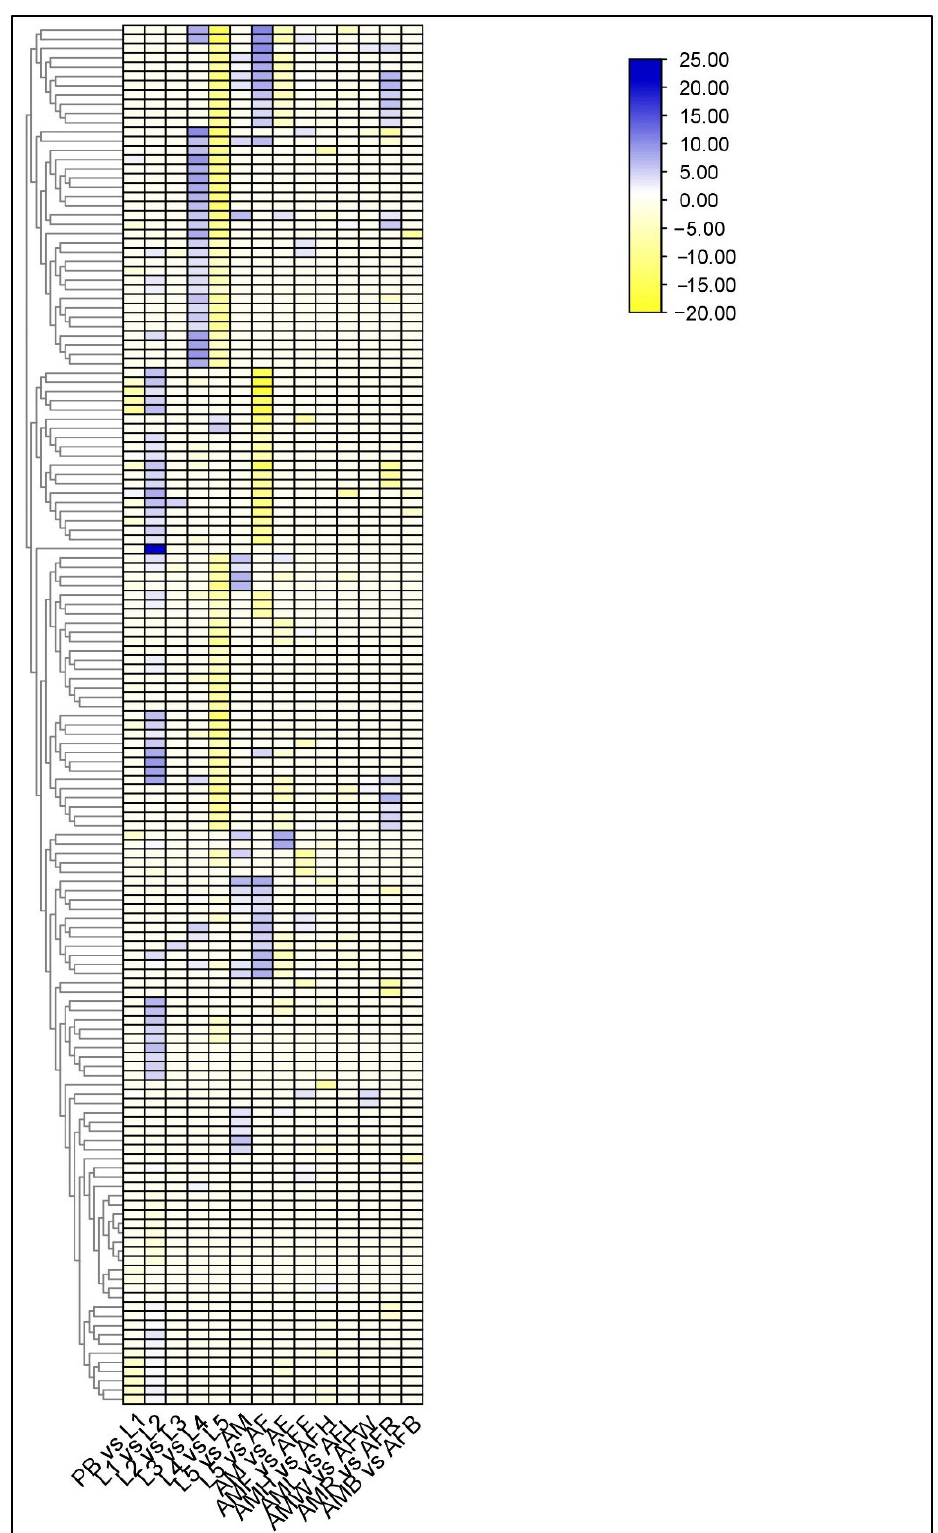
Figure 3. Identification of genes assigned to the cuticle protein in the P. bremeri transcriptome. Heatmap representation of the differentially expressed genes of cuticle proteins.